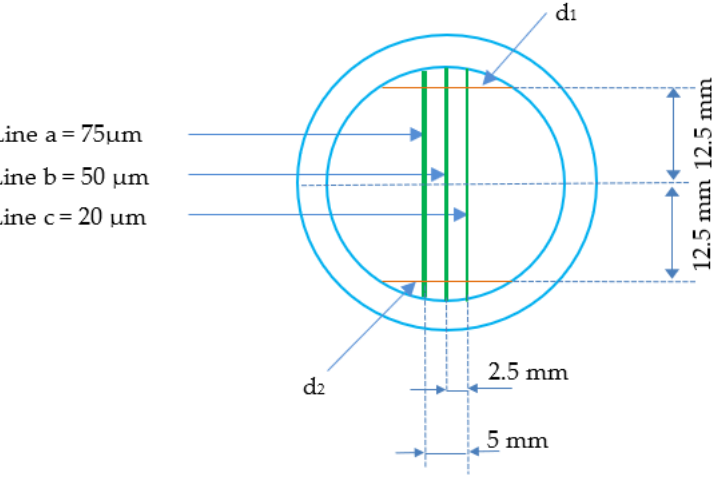
Figure 1. Test block used for detail reproduction and compatibility with gypsum of commercial and Exp VPS impression materials ( n = 5). Exp VPS impression materials ( n =